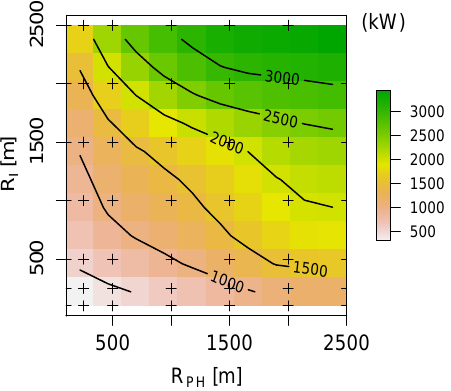
Figure 10. Mean HP for the 243 maximum values.